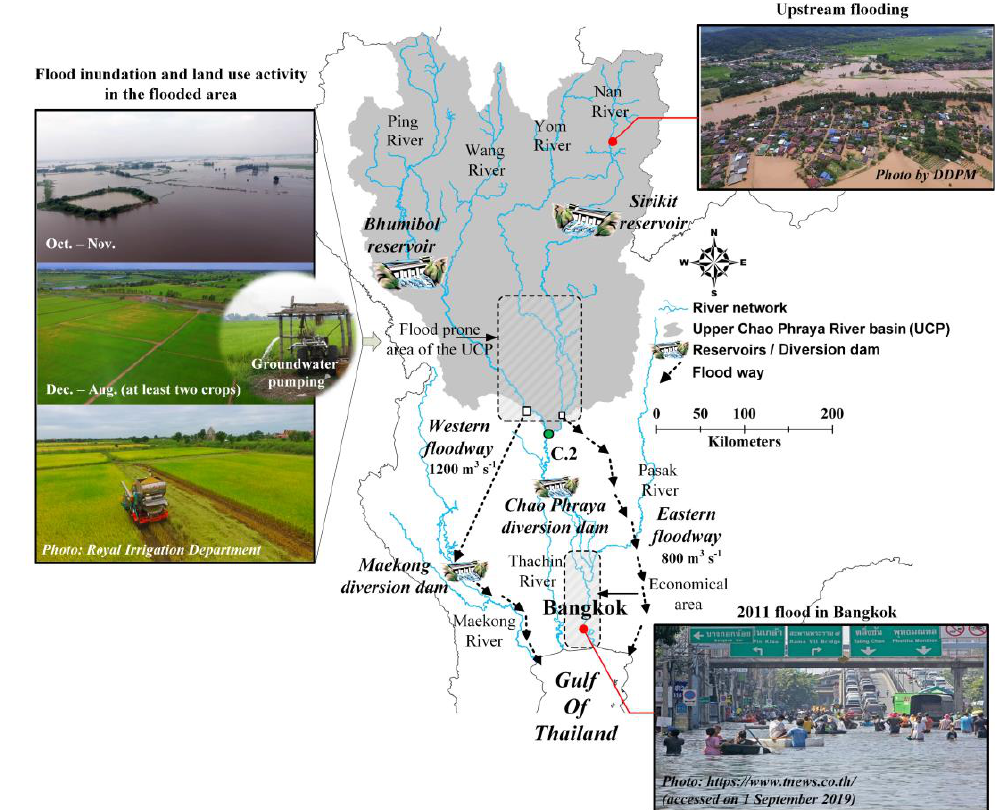
Figure 4. The Chao Phraya river network and scheme of floodways.